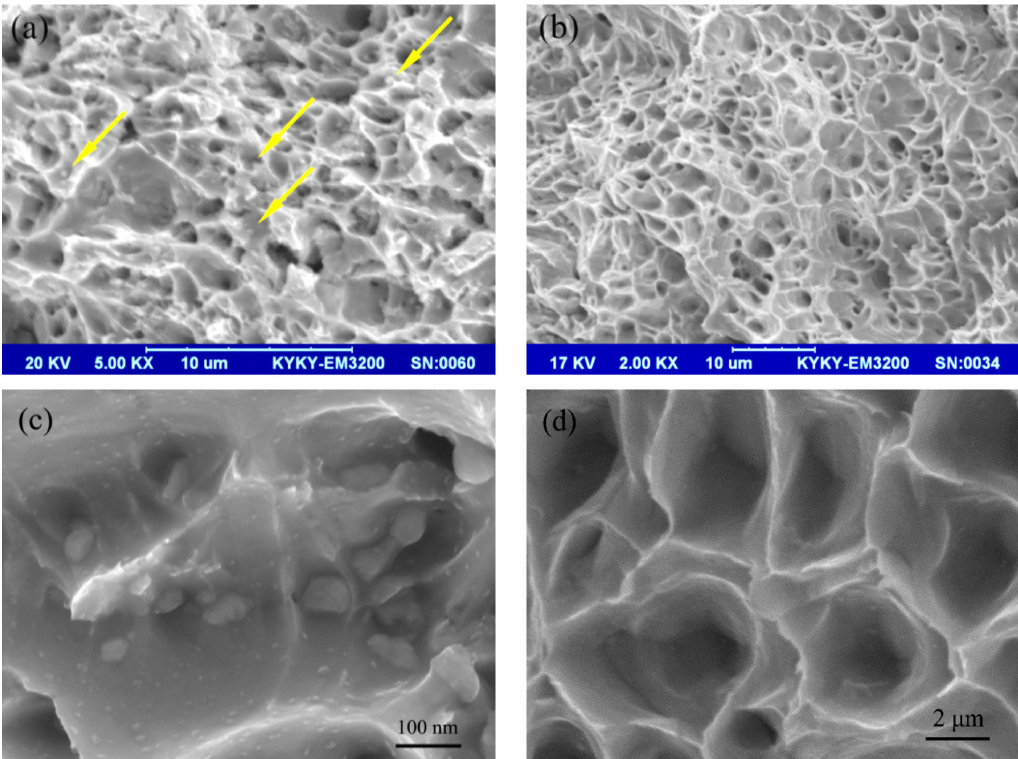
Figure 5. SEM image of the fracture of the nano-Gd 2 O 3 /Cu composite ( a , c ) and pure Cu ( b , d ). Phase analysis was adopted to further confirm the components of nanoparticles dispersed in the Cu matrix. Figure 6a presents a TEM morphology image of the nano- Gd 2 O 3 /Cu composite. Dark particles (marked as A) and a large bright flat area (marked as B) were seen, and the corresponding EDS spectrum at A and B in Figure 6a are given in Figure 6c,d. Figure 6b shows the selected area diffraction pattern. According to the EDS spectrum in Figure 6c, only Gd and O elements were found in dark area A, and the atomic ratio of the two elements was close to 3:2, illustrating that the nano-Gd 2 O 3 particles could be synthesized in the composite. The main element in B was Cu (Figure 6d), indicating that the bright area was the Cu matrix. In further analysis with the selected area diffraction pattern in Figure 6 b, the diffraction spots marked in red matched with the [ − 1–10], [ − 110], and [ − 200] planes of Gd 2 O 3 , and its zone axis was [001], which confirmed that the dark spherical particle area was the Gd 2 O 3 phase. The diffraction points marked in yellow matched with the [ − 20–2], [220], and [02–2] planes of Cu, and its zone axis was [ − 111], indicating that the bright region was the Cu